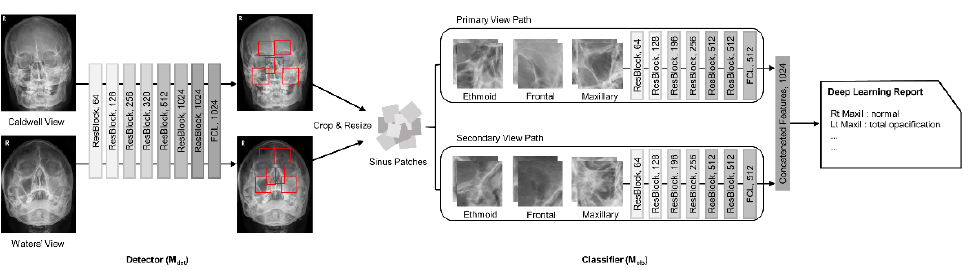
Figure 3. Overview of the proposed network architecture. The network consists of a detector (M det ), which localizes sinuses with a bounding box, and a classifier (M cls ), which classifies sinusitis with 4-leveled labels. It combines the information of both Caldwell and Waters’ views. For the modified model, which uses only the primary view (denoted as single primary view model), the network path of the second row is removed (vice versa for the single secondary view model, which uses only the secondary view).